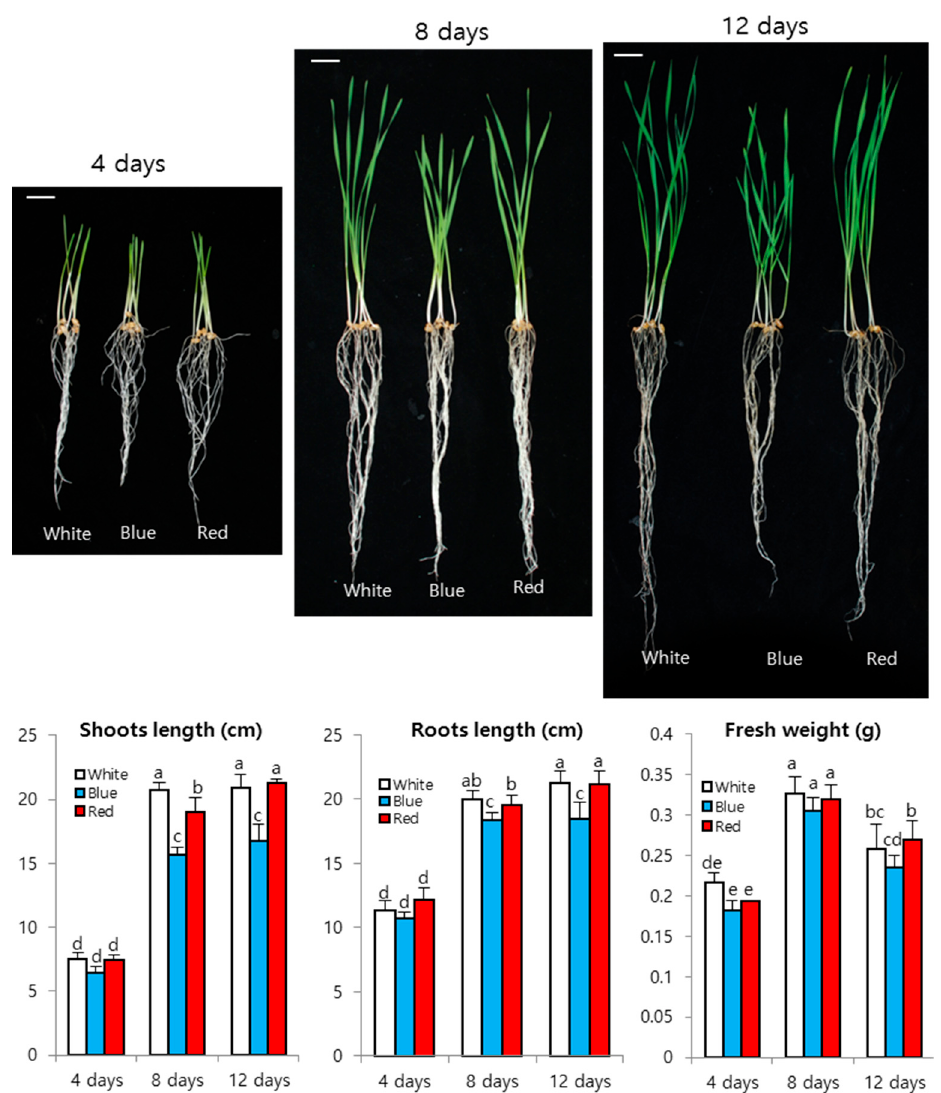
Figure 2. Development of wheat sprout at 4, 8, and 12 days of growth under white, blue, and red LED lights. The scale bars represent 2 cm. The means and standard deviations were obtained from three independent experiments. Letters a–e indicate significant differences ( p < 0.05).